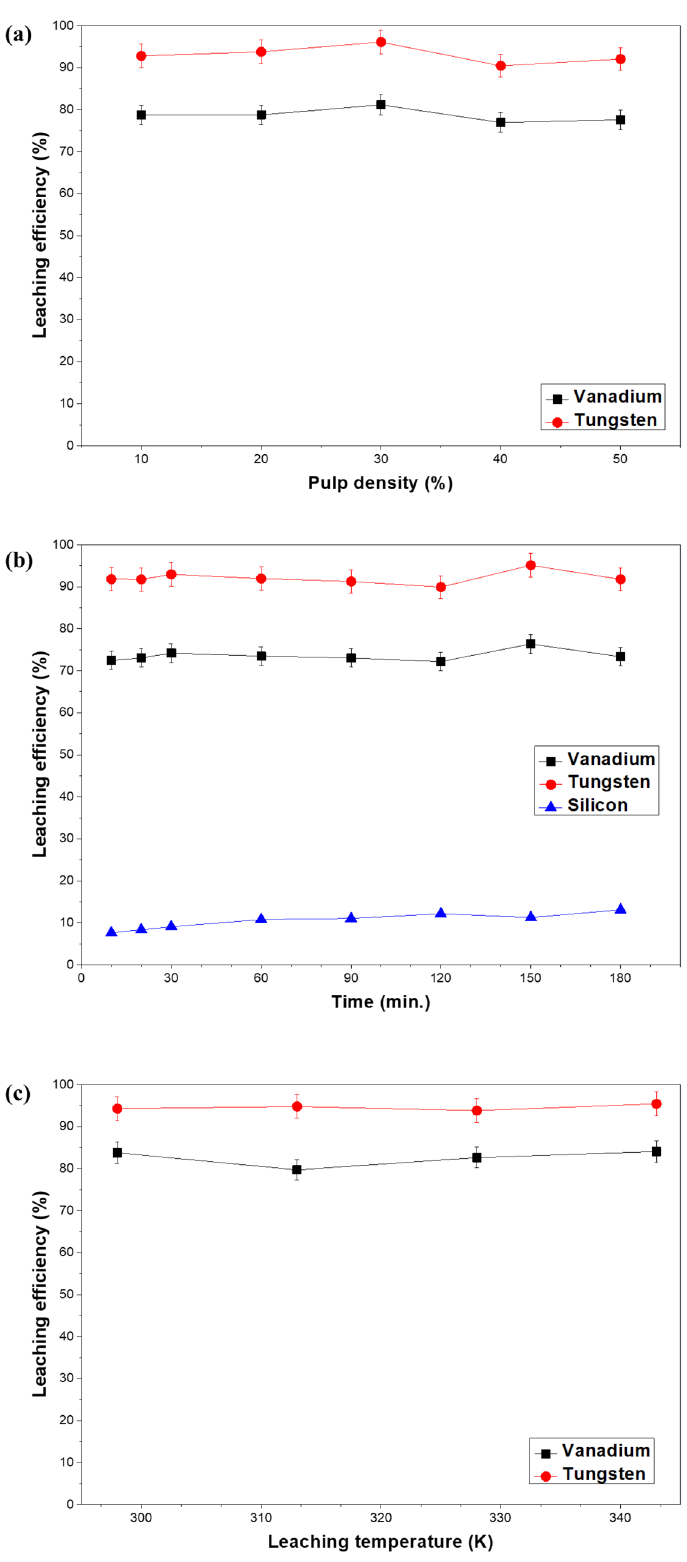
Figure 3. Effect of pulp density ( a ), time ( b ), and temperature ( c ) for leaching of the spent SCR